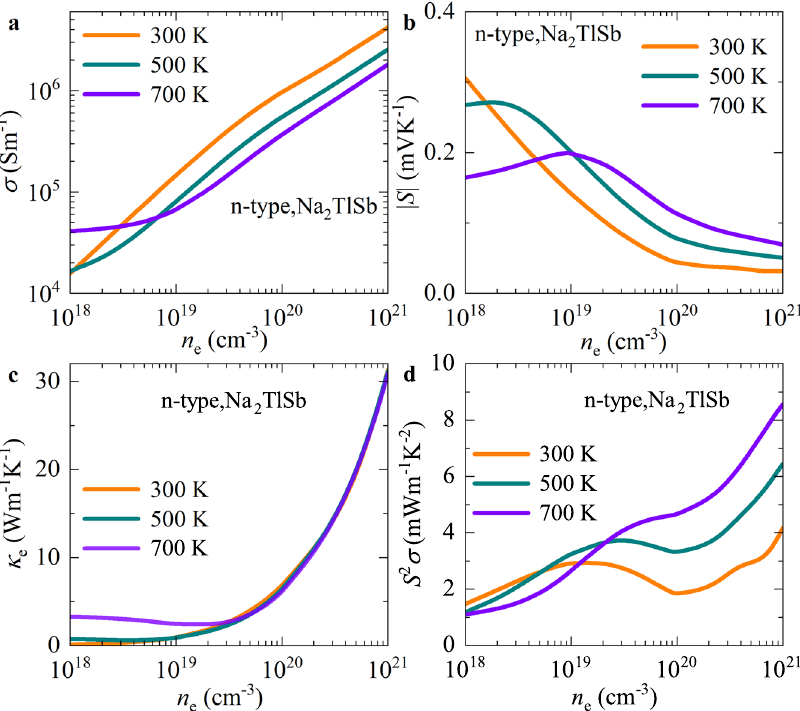
Fig. 7 Electronic transport parameters. The calculated electronic transport parameters for n-type Na 2 TlSb at 300, 500, and 700 K, respectively. a Electrical conductivity σ . b The Seebeck coef fi cient ∣ S ∣ . c The electronic thermal conductivity κ e . d TE power factor. The SOC is also included in the